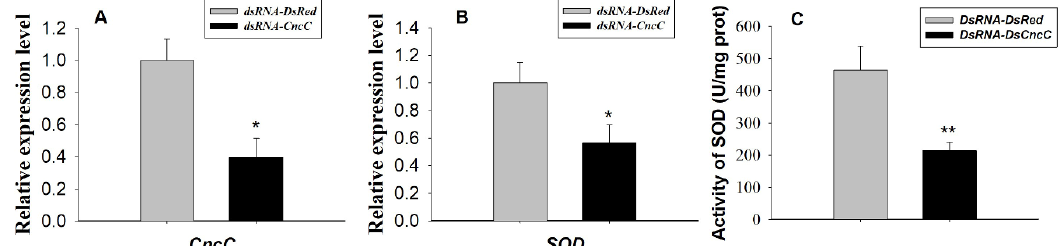
Figure 5. RNAi analyses Sf CncC regulate SOD transcriptional levels in Sf9 cells. The mRNA transcription level (means ± SD) of Sf CncC ( A ) and SOD ( B ); and the activity of SOD ( C ) in in Sf9 cells transfected with CncC dsRNA and DsRed dsRNA. The error bars indicate 95% confidence intervals (n = 3). * on the columns indicated significant difference by Student's t-text ( p < 0.05), ** indicated significant difference by student's t-text ( p < 0.01).